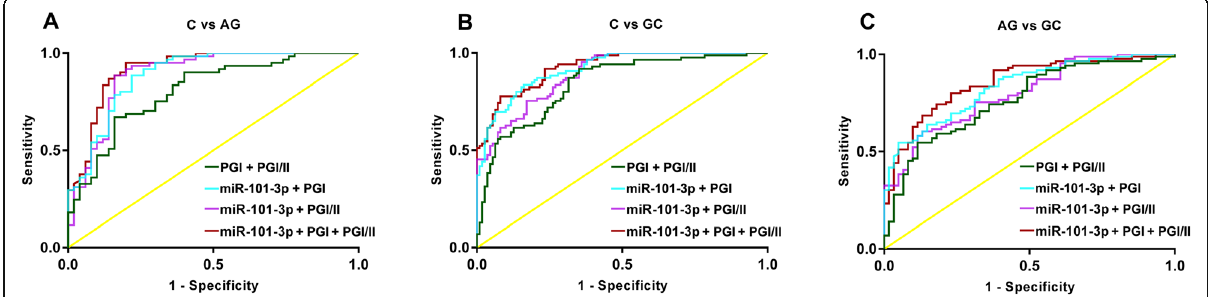
Fig. 2 The diagnostic value of serum marker combinations on AG and GC was analyzed by ROC analysis. a , the ROC curves of the combinations between normal controls (C) and AG patients; b , the ROC curves of the combinations between normal controls (C) and GC patients; c , the ROC curves of the combinations between AG and GC